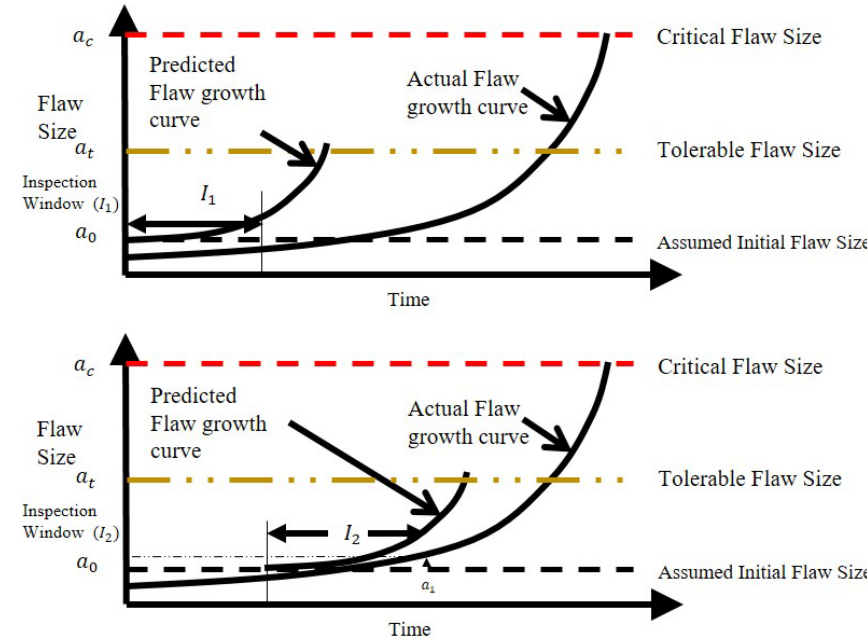
Figure 9. Schematic representation of damage-tolerant fracture mechanics approach, adapted from Anderson (2005).